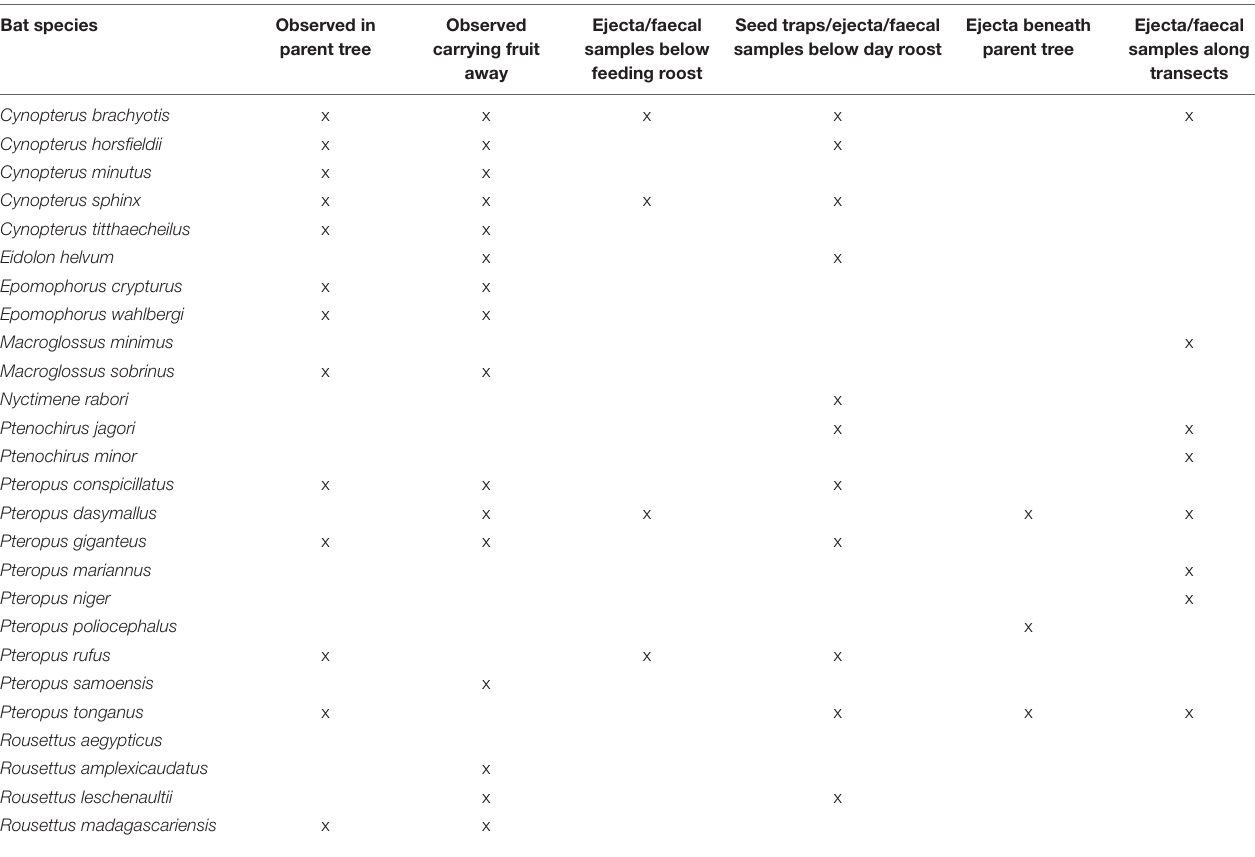
TABLE 4 | Seed dispersal study methods according to pteropodid